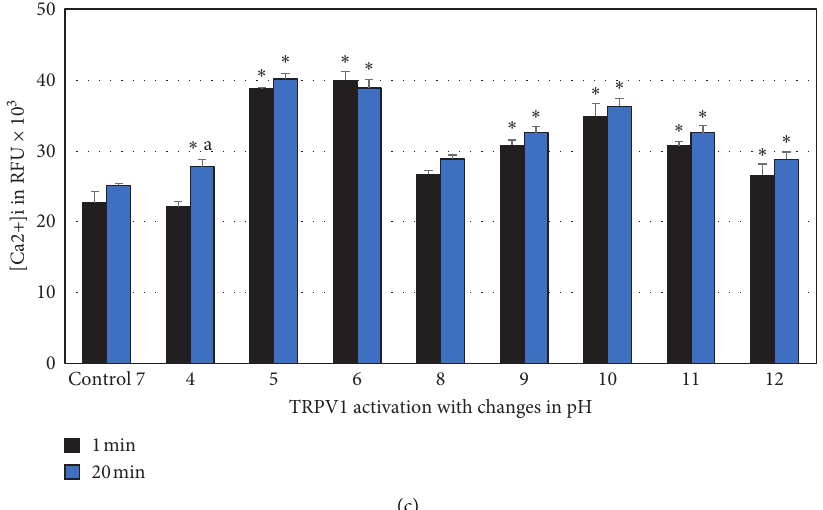
Figure 6: Chemical, thermal, and pH stimuli of TRPV1 receptor in hOLCs. In the polymodal stimulation assays, 1 and 20min of exposure to the stimulus were evaluated using the Fluo 4 AM probe. (a) Chemical stimulation of the TRPV1 receptor. Statistically significant differences were found between the test groups at the different exposure times evaluated (1 and 20min) with both CAP and EUG. TRPV1 receptor desensitization was confirmed at 20min with both vanilloid substances, and no differences from the control were identified. (b) Thermal stimulation activation at 43 ° C. No statistically significant differences were found between the test groups at the different exposure times evaluated (1 and 20min). (c) Stimulation with changes in pH. Activation was marked at pH 5 and 6. Relative fluorescence units (RFU) were detected at a wavelength of 494/520nm (excitation/emission) using a TECAN microplate reader. Results are shown as the mean ± SD of three independent experiments in triplicate ( n � 9). Each group was compared to its respective control, and the asterisks show statistically significant differences between them ( p < 0 . 05). The lowercase letter (a) shows statistically significant differences between the test groups at the different times evaluated (1 and 20min) ( p < 0 .